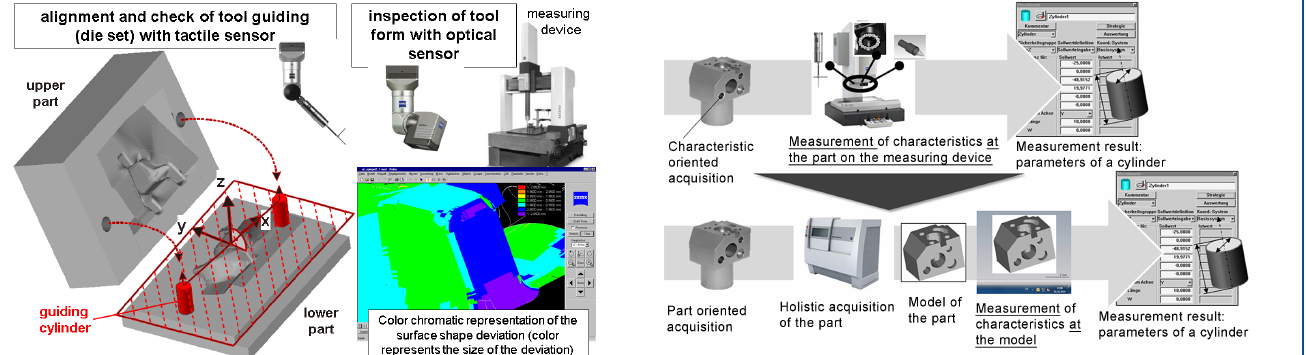
Figure 8. Application example of combined sensors use for holistic inspection of a forming tool on a coordinate measuring machine (Imkamp, 2015).